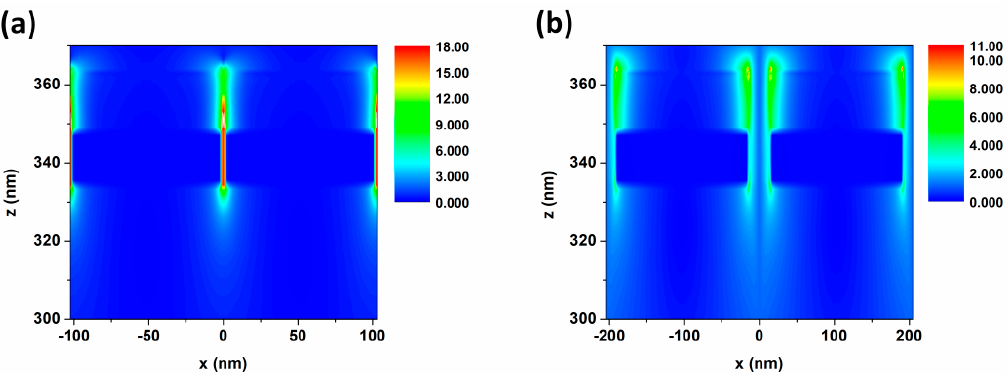
Figure 3. Cross-sectional electric field distributions of arrays with period a = 103 nm ( a ); and 205 nm ( b ).